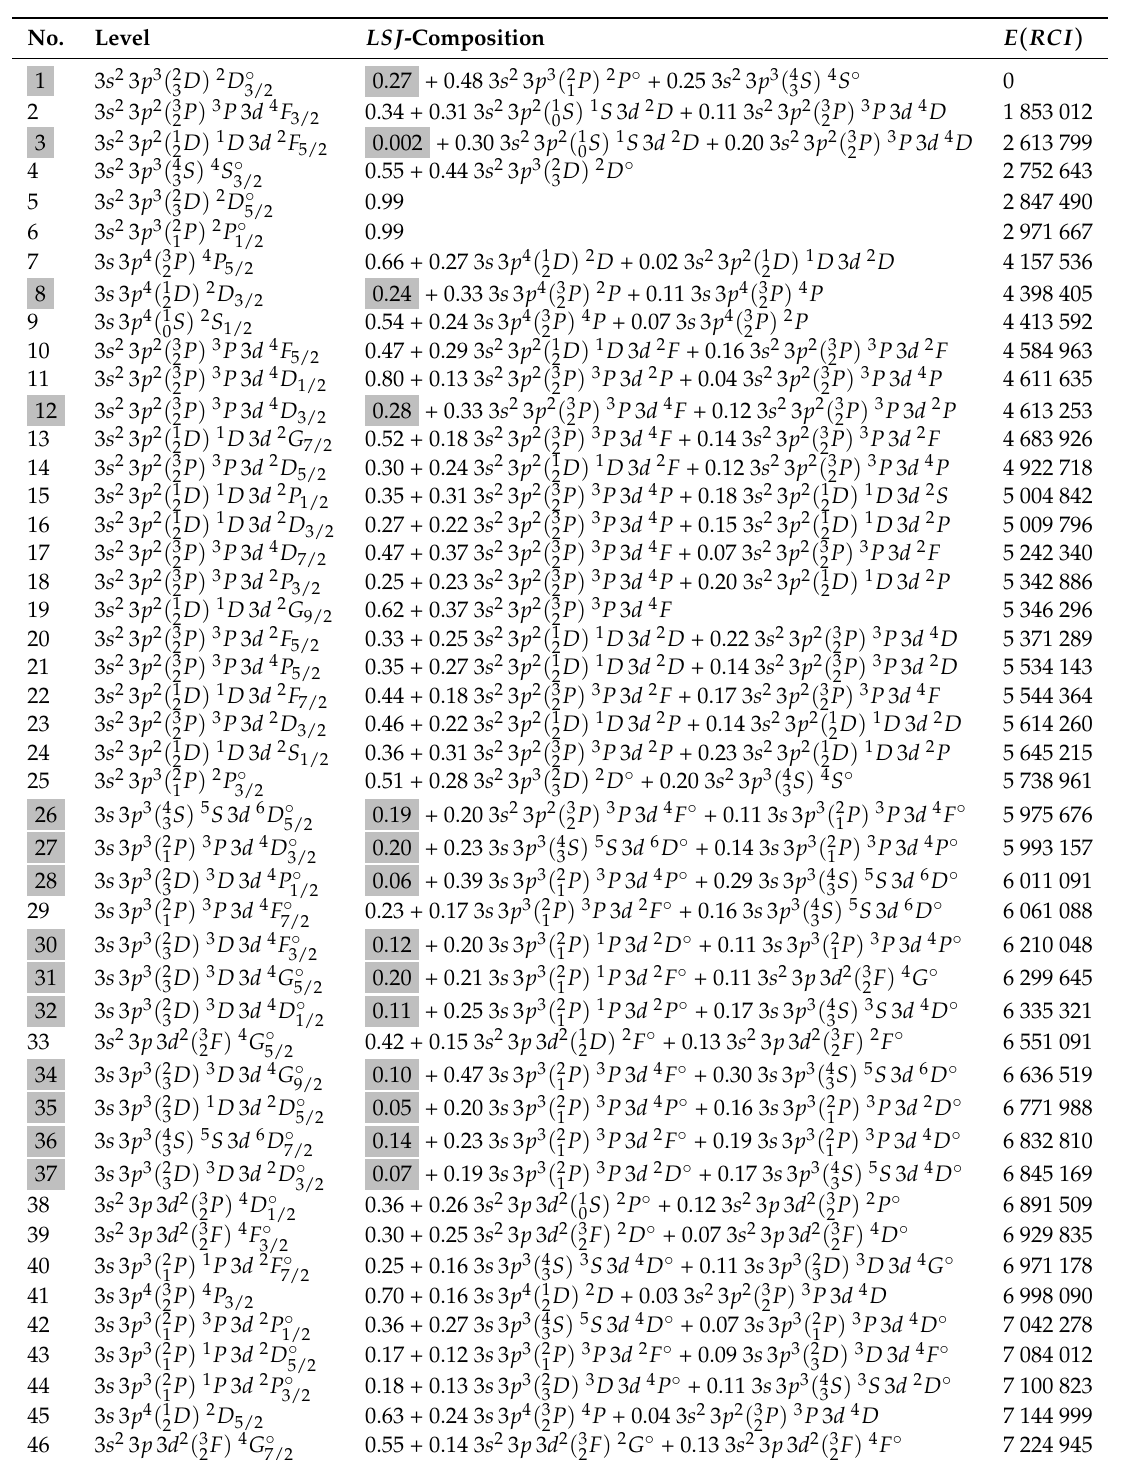
Table 3. LSJ -composition and energy levels in cm − 1 for P-like W from relativistic configuration interaction (RCI) calculations. Levels that are assigned new labels using the JJ2LSJ program are marked with grey